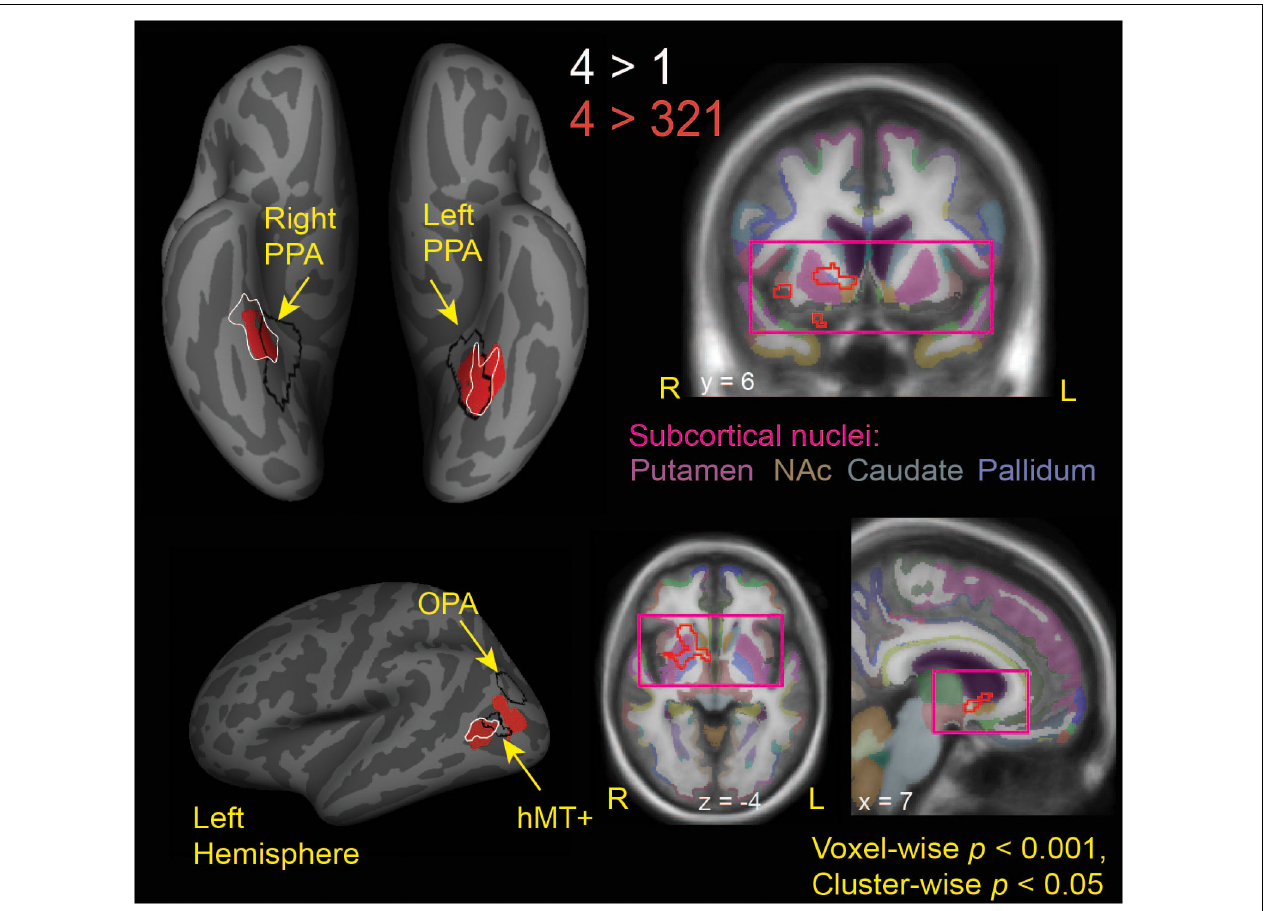
FIGURE 3 | Brain regions modulated by aesthetic appreciation of landscape movies. Significant clusters of activations from a whole-brain beta series GLM analysis are shown for group contrasts of 4 vs. 1 (white outlines) and 4 vs. 321 (solid red: cortical, red outline: subcortical) levels of aesthetic appeal. N = 24. Black outlines show the scene-selective regions as found by the functional localizer task. PPA, parahippocampal place area; OPA, occipital place area; NAc, Nucleus Accumbens.